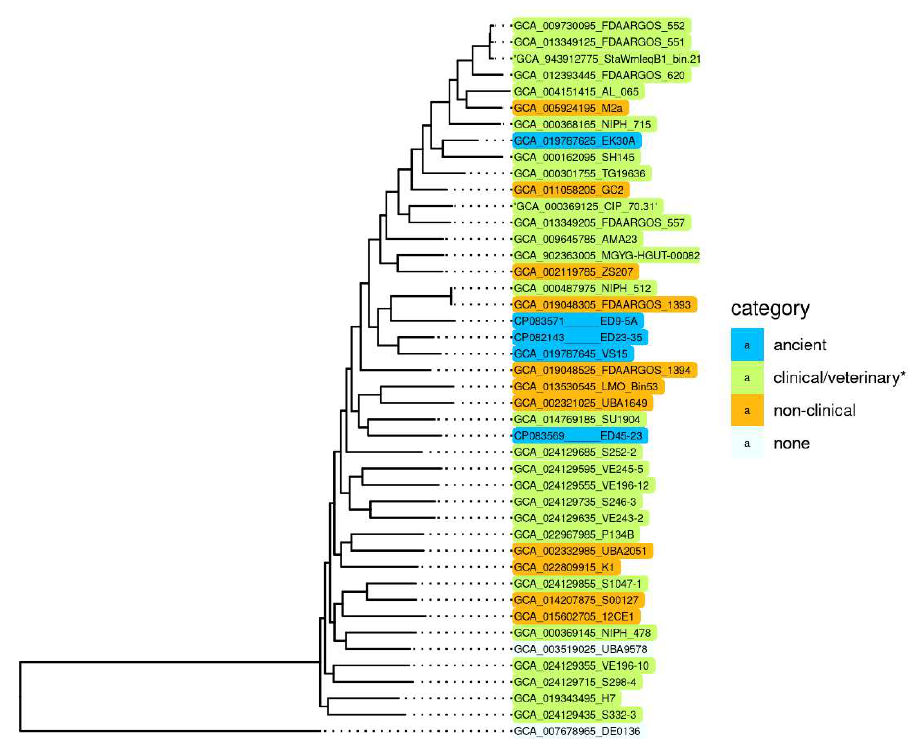
Figure 1. Genome-based phylogeny of A. lwoffii . The maximum likelihood tree is based on con- catenated nucleotide sequences of 847 single copy genes. * Strains isolated from samples of healthy